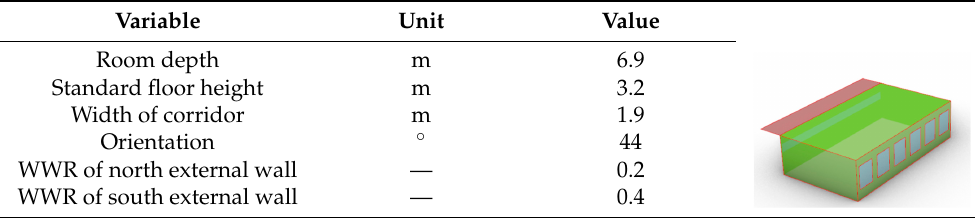
Table 5. The parameters of the centroid 3 scheme.